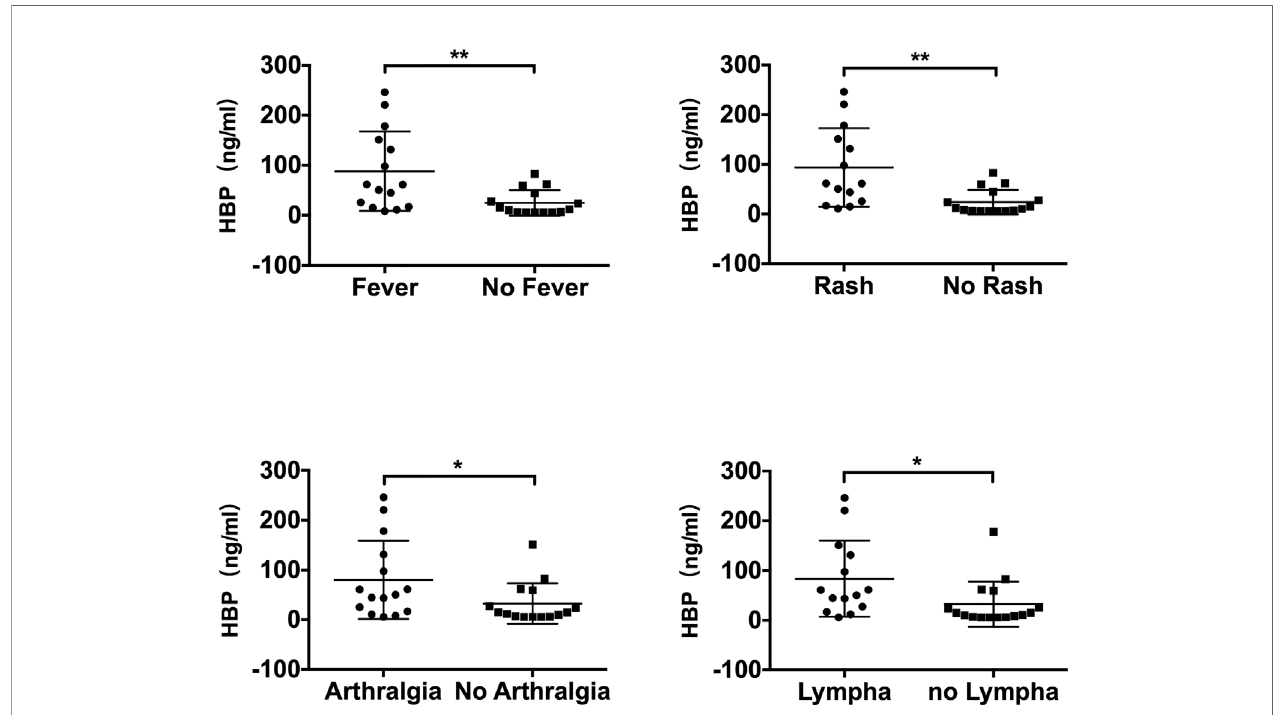
FIGURE 3 | Comparison of serum HBP levels in patients with adult-onset Still ’ s disease with different measures of clinical disease manifestation ( “ lympha ” is short for “ lymphadenopathy ” ). Data are presented as mean and interquartile range and signi fi cance was calculated using two-tailed Student ’ s t-test. * P < 0.05, ** P < 0.01.